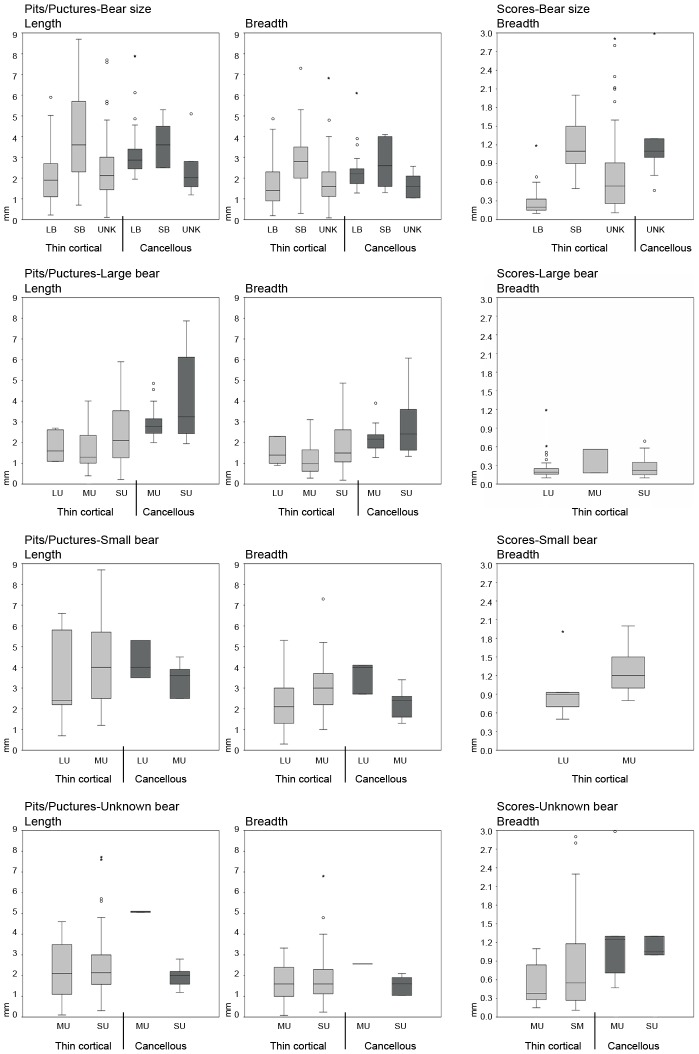
Dimensions (mm) of bear tooth pits, punctures and scores (upper and lower fence) occurring on cancellous bone and on thin cortical bone, plotted by size of bear consumers and size of ungulate bones (see Table S1 for descriptive statistics).LB =  Large bear; SB =  Small bear; Unknown bear =  UNK; LU =  Large ungulate; MU =  Medium ungulate; SU =  Small ungulate.